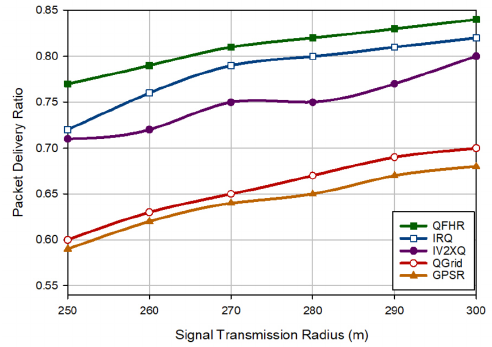
Figure 11. PDR in different approaches based on